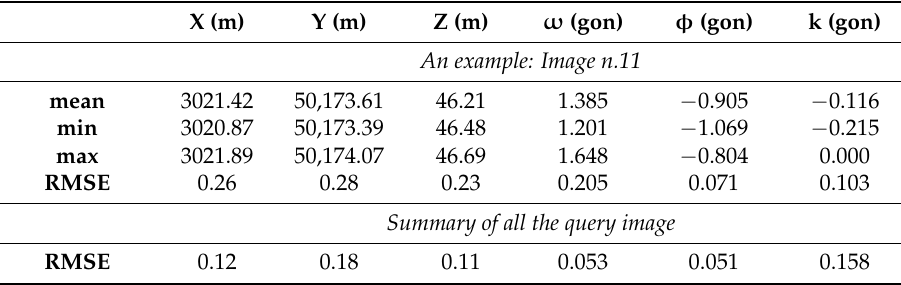
Table 7. Reliability analysis in Bangbae station data